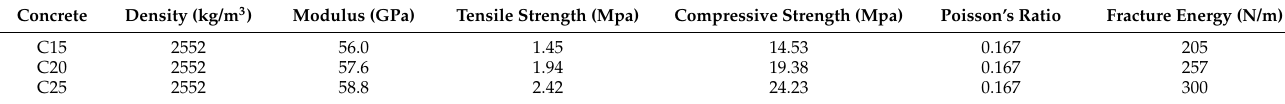
Table 1. Concrete properties of the Guandi gravity